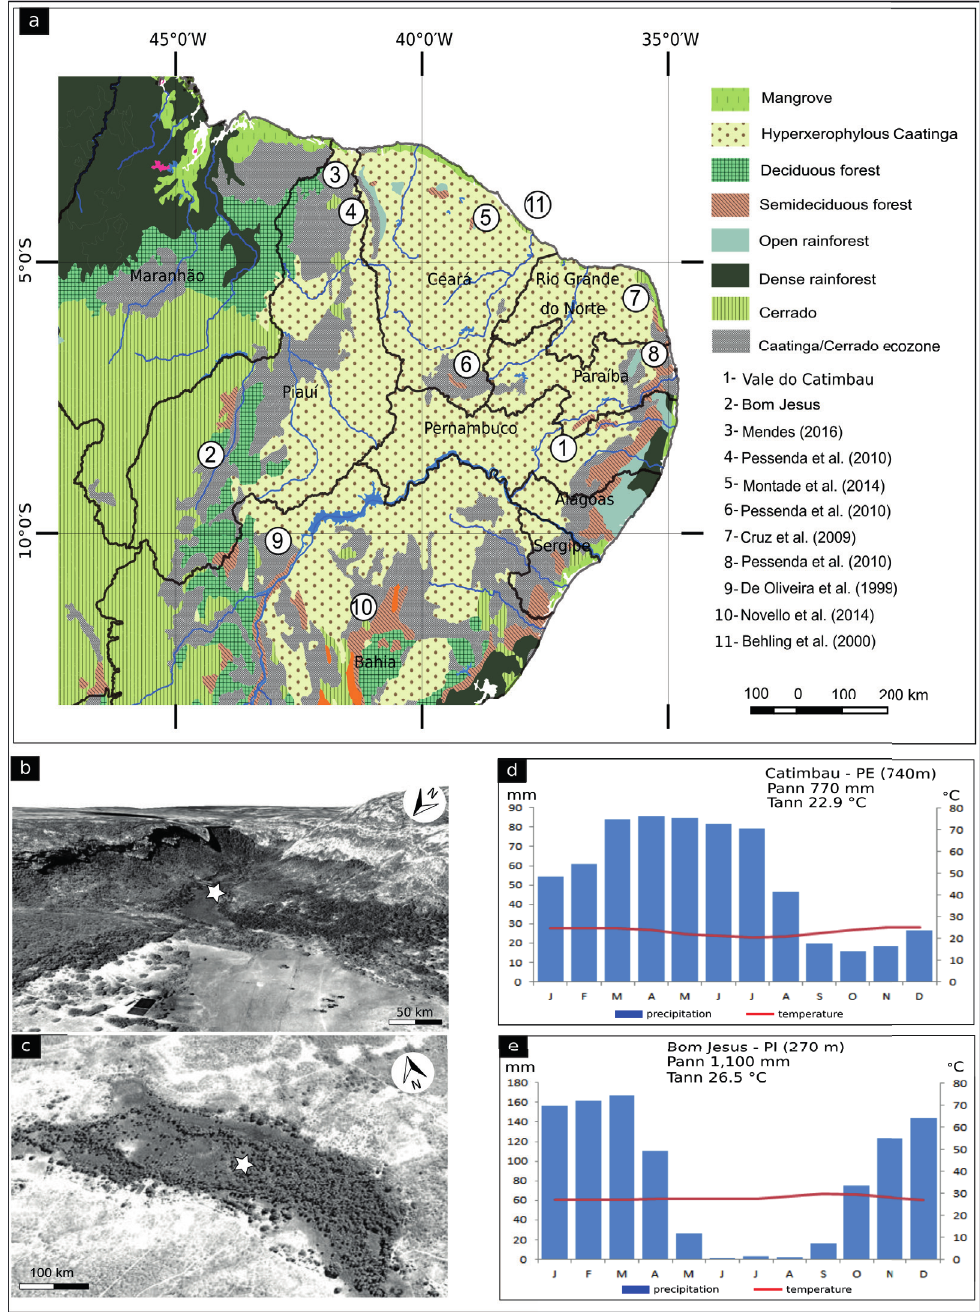
Figure 1 - ( a ) Location map of Catimbau (1) and Bom Jesus (2) sites in relation to important paleoclimatic studies, showing the vegetational distribution of NE Brazil, drawn by Q GIS 2.18 Las Palmas software. Satellite images for both sites are in ( b ) and ( c ), respectively and reveal the position of the sampled sites in the environment. Ombrothermic diagrams show mean monthly values of temperature and precipitation and annual precipitation (Pann) and temperature (Tann), for both sites ( d ) and ( e ) respectively, calculated for the last 45 years (data from the National Institute of Meteorology, available at: www.inmet.gov. br/portal). Paleocological studies discussed in the present work are: 3 – Parnaíba River (Mendes 2016); 4 – PARNA (Pessenda